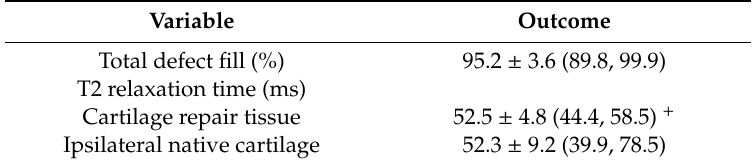
Table 2. Structural repair outcomes by 3 dimensional MRI at 7.9 years follow-up (n = 14).